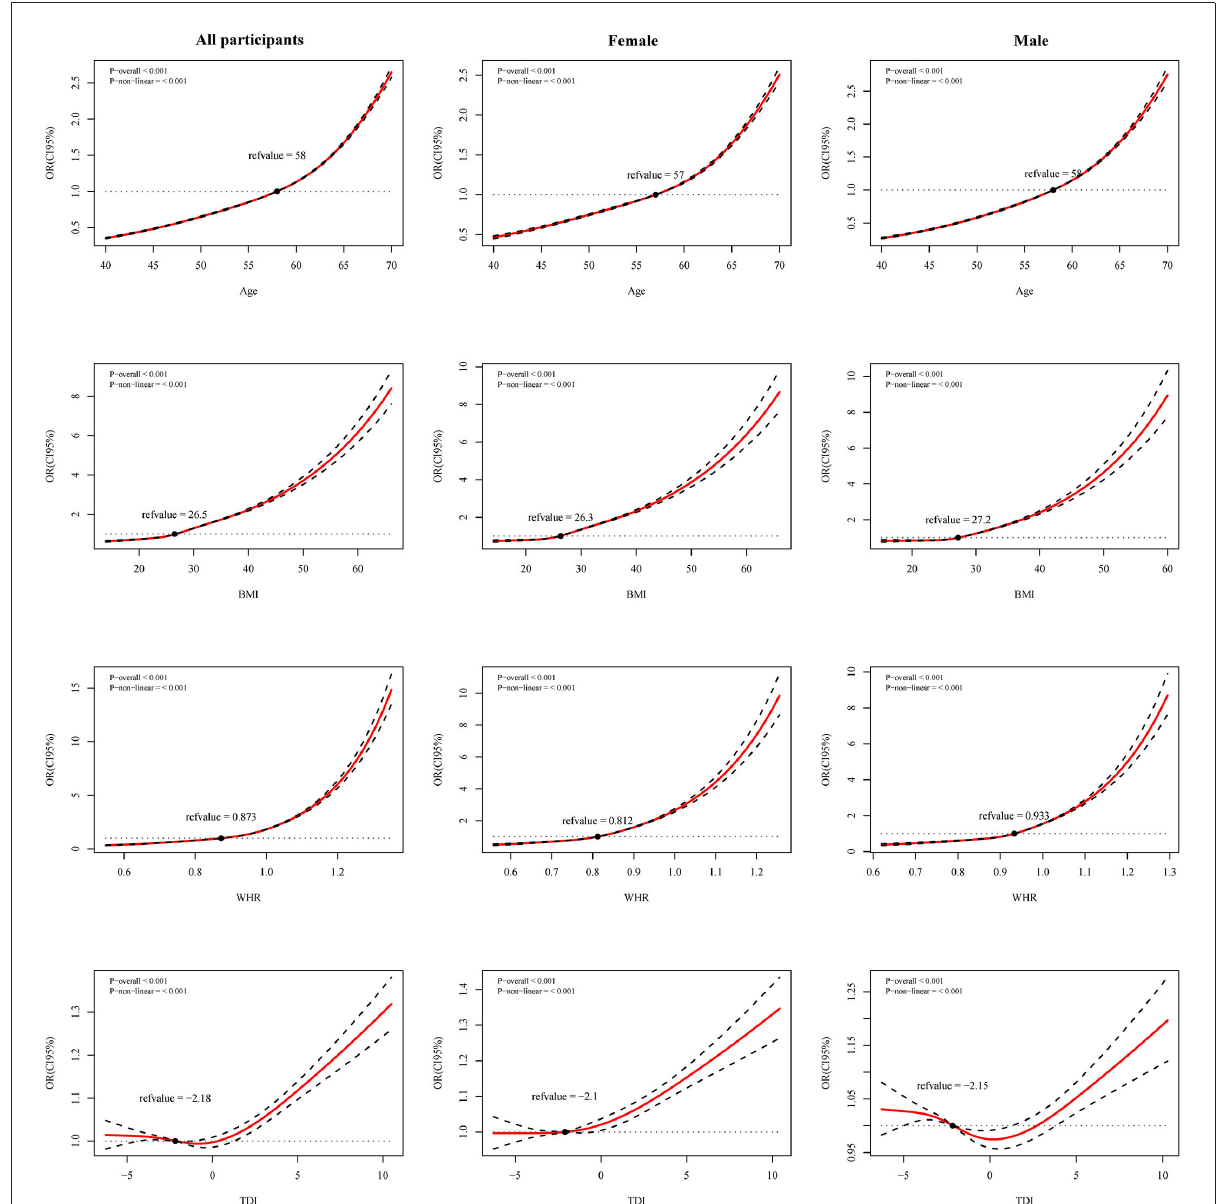
FIGURE2 Restricted cubic spline (RCS) curves for age, Townsend deprivation index (TDI), waist-hip ratio (WHR) and body mass index (BMI) with Charlson comorbidity index (CCI) risk in all participants, female and male. Adjusted for ethnicity, smoking, alcohol, income, and maternal smoking at birth.